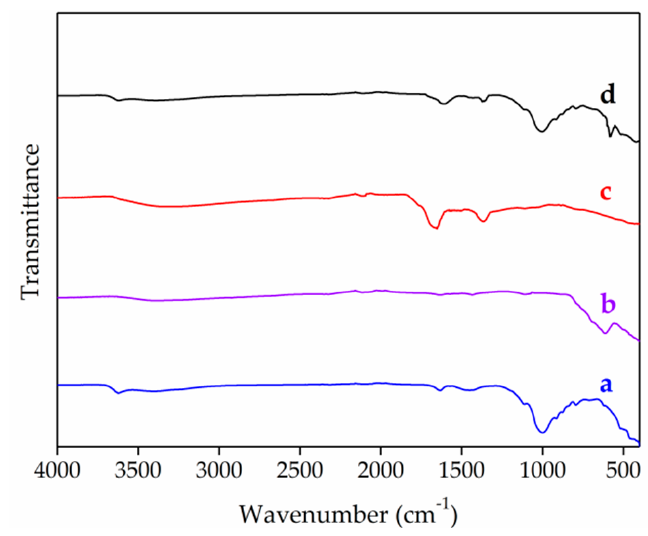
Figure 3. FTIR of ( a ) Mt; ( b ) Fe 3 O 4 NPs; ( c ) HA; and ( d ) MFH nanocomposites.